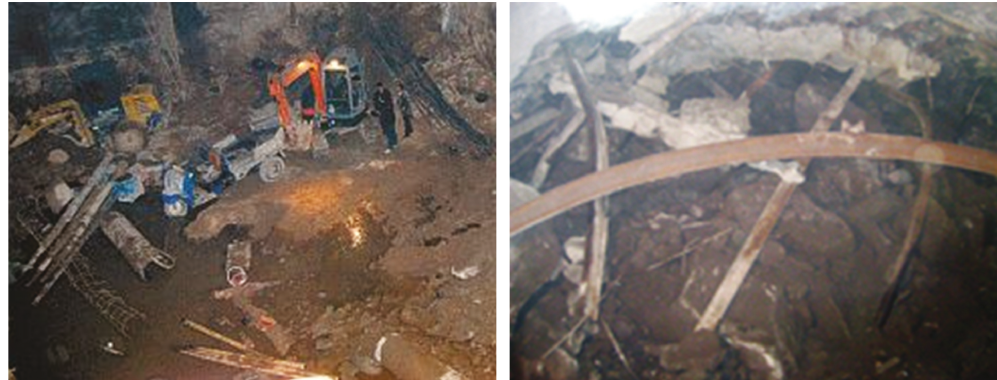
Figure 1: A collapse in a